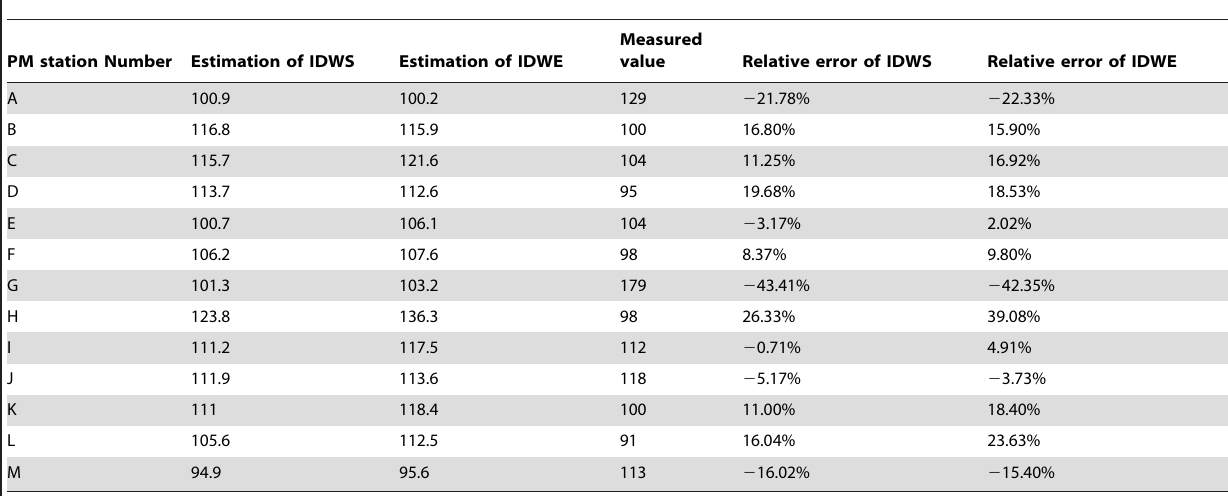
Table 2. Distributions of the relative errors of the two methods for the daily PM 2.5 estimation on 21st May.